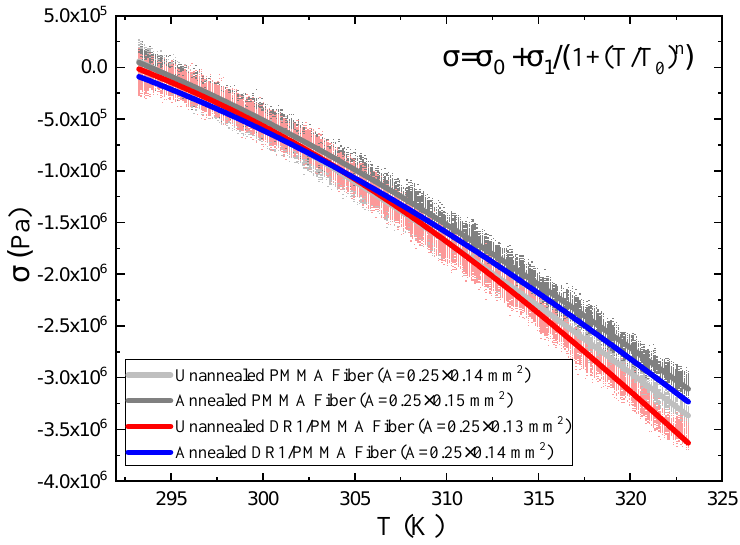
Figure 6. Change in stress of a stretched fiber as a function of temperature for PMMA and DR1/PMMA fibers. Note that the fiber is slightly stretched between the clamps to prevent buckling; thus, when the fiber expands, the stress decreases as the stretching strain decreases. σ 0 is an arbitrary offset due to the nonzero reading of the sensor when no stress is